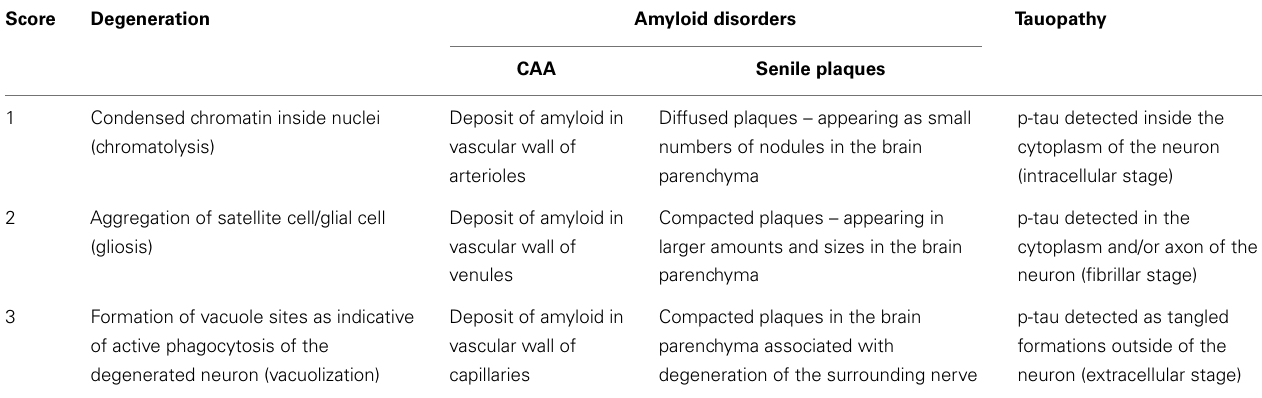
Table 2 | Scoring criteria of the histopathology of the brain .